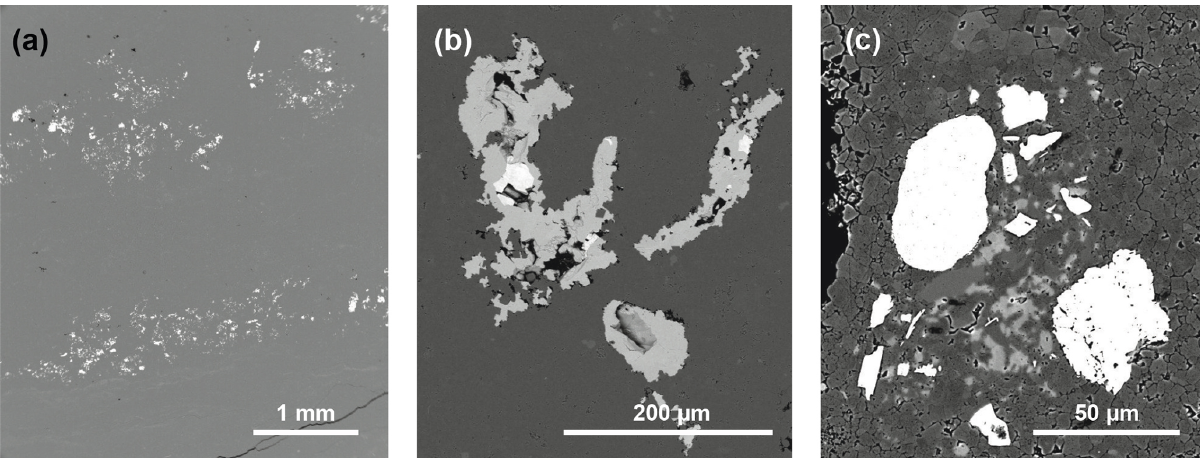
Figure 5. SEM images of dolomites in backscatter mode: (a) overview showing a dolomite layer containing celestine inclusions (bright areas; sample TZ14-9d; 95m); (b) celestine inclusion with barite in the centre (same sample as in a ); (c) barite crystals in dolomicrite (sample TZ14-4; 65m).